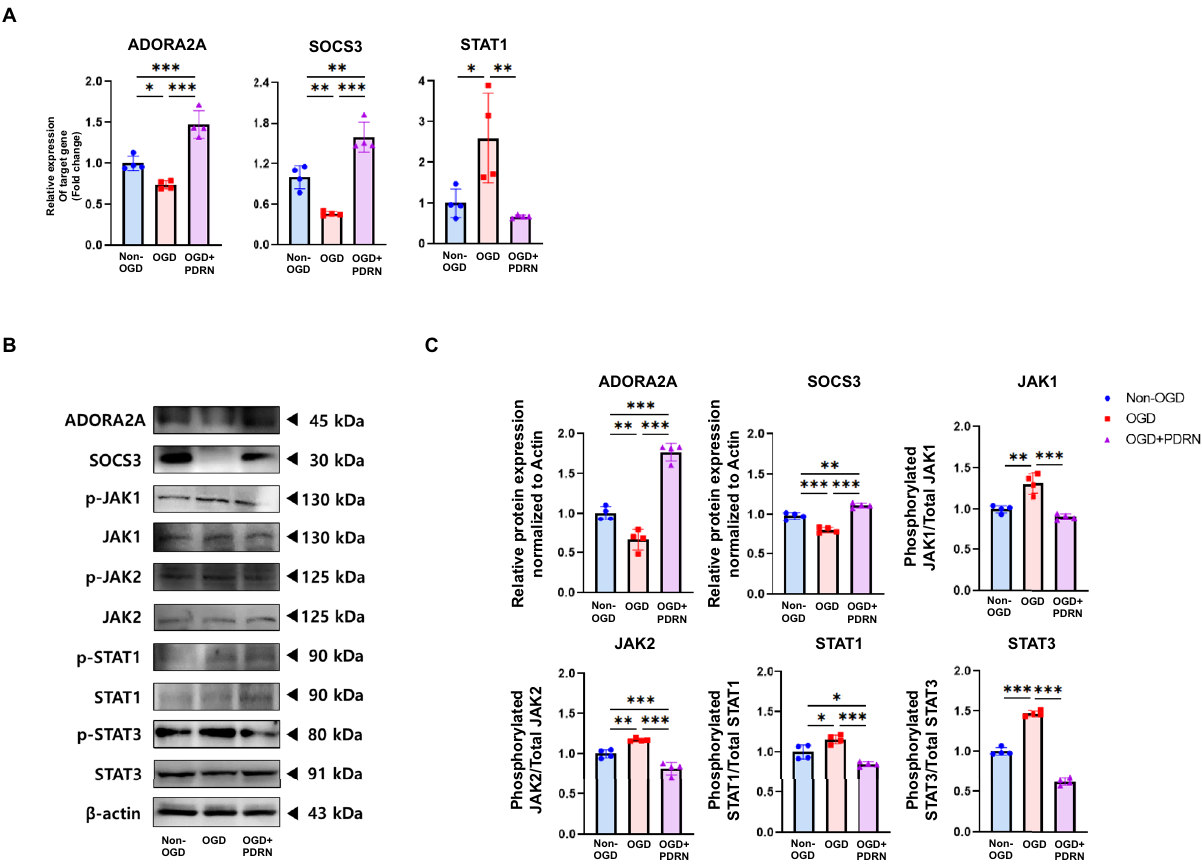
Figure 3. Effect of PDRN on JAK/STAT pathway of in vitro I/R Injury model. ( A ) The relative gene expression of ADORA2A, SOCS3, and STAT1 in Non-OGD, OGD, and OGD + PDRN groups detected by RT-qPCR. ( B ) Western blot analysis of the JAK/STAT pathway in Non-OGD, OGD, and OGD + PDRN groups ( C ) Quantification of western blotting signals for the JAK/STAT pathway. Values are presented as means ± SEM. Statistically significant differences are shown as * p < 0.05, ** p < 0.01, *** p <